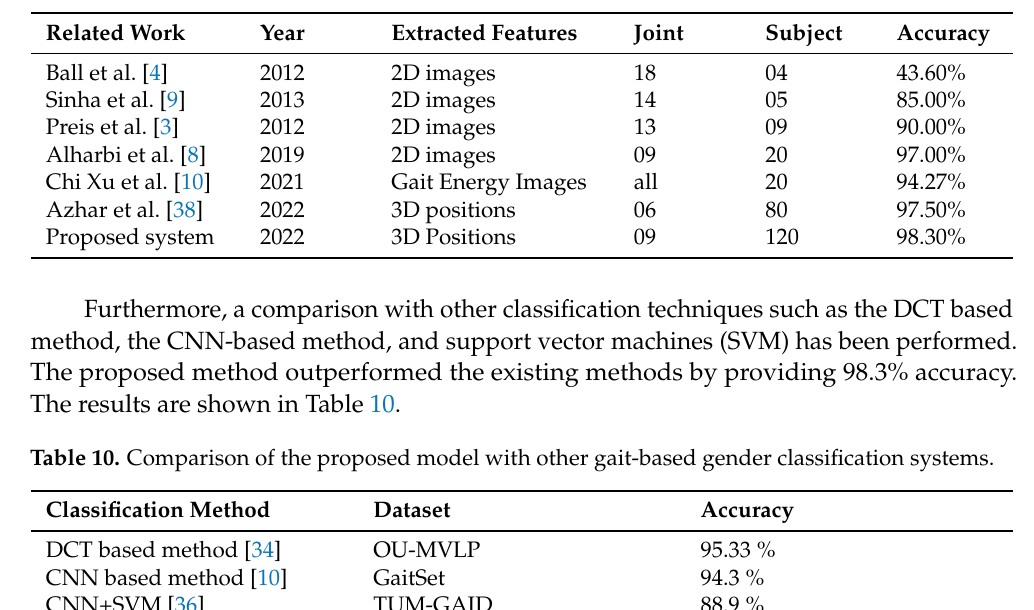
Table 9. Comparison with current gait recognition techniques.